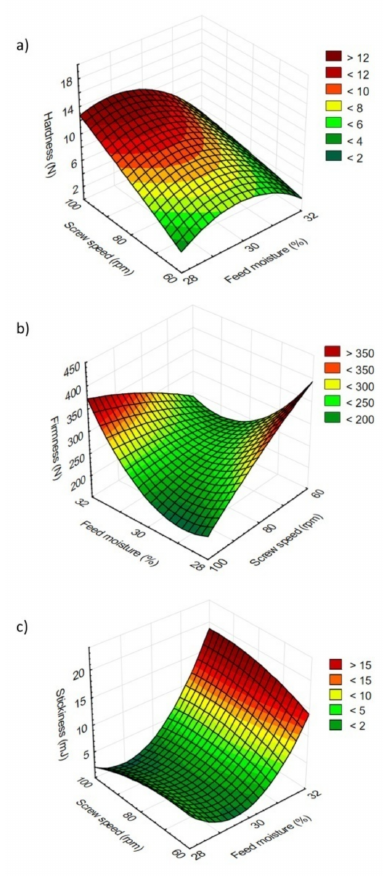
Figure 2. Hardness of dry pasta ( a ) as well as firmness ( b ) and stickiness ( c ) of hydrated pasta as affected by feed moisture and screw speed during the processing of rice